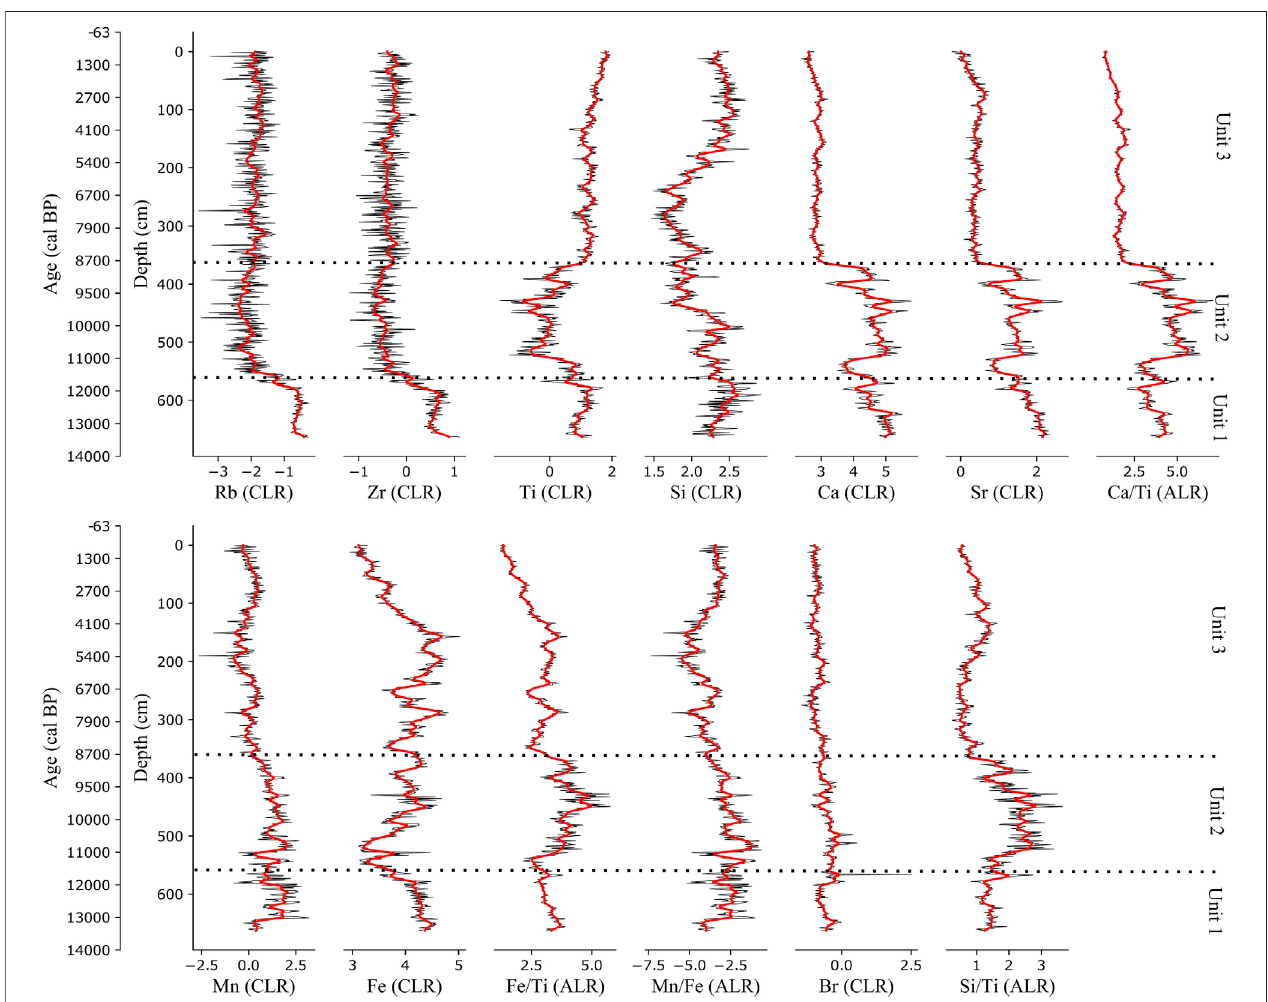
FIGURE 8 | XRF pro fi les of selected elements and elemental ratios along the core. The thin black lines represent continuous measurements (sampling interval of 10 mm), and the thicker red lines represent the 5-point running mean.